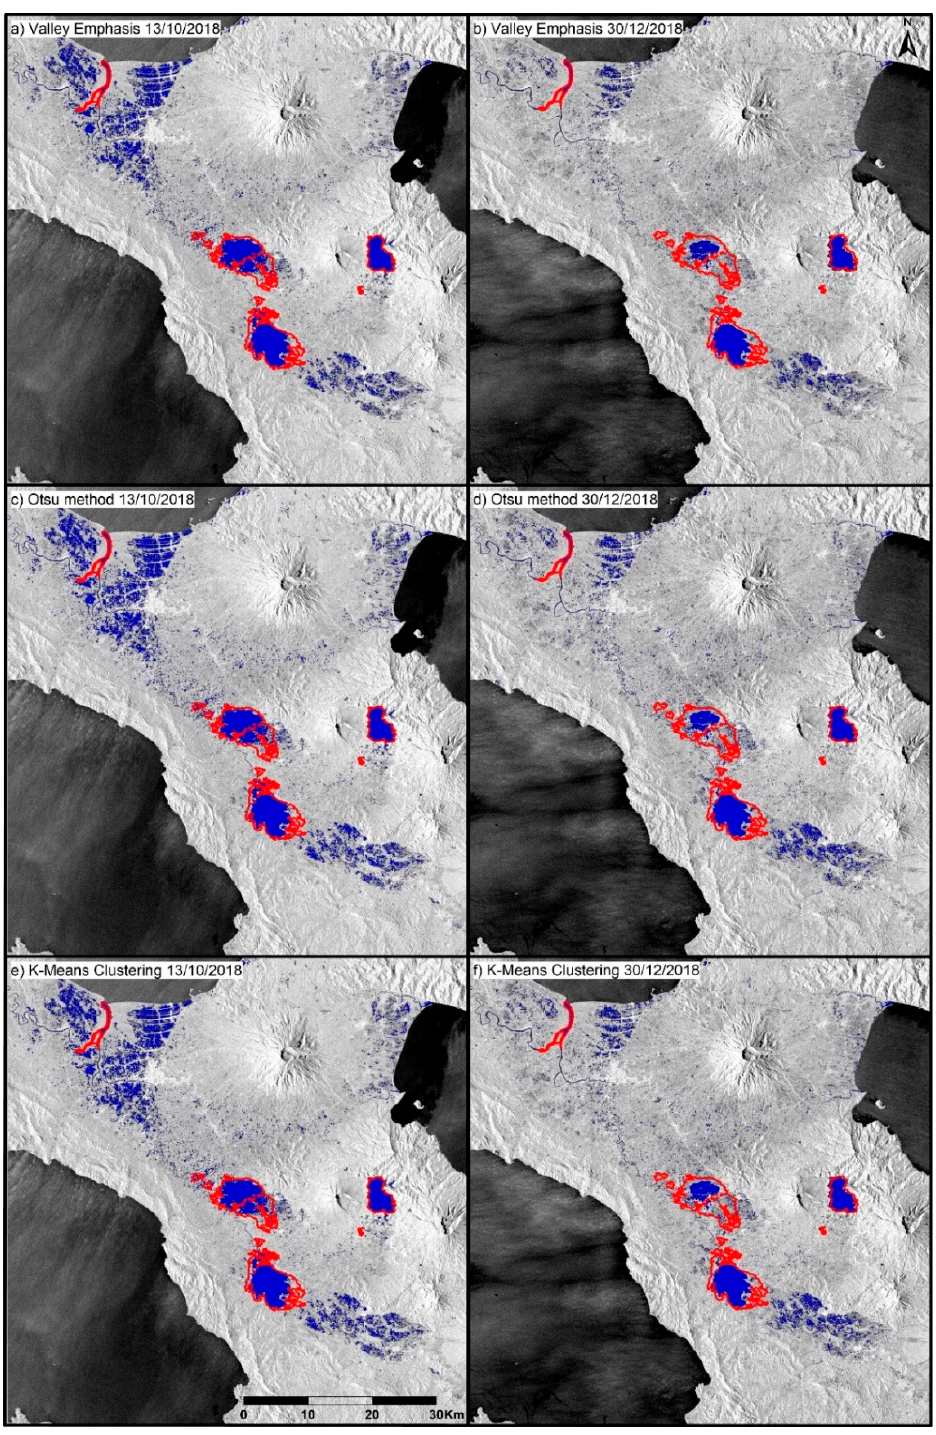
Figure 6. Examples of results in terms of open water extent obtained by multiple methods. Blue areas represent the extracted open water features, and red polygons represent SWBD water body boundaries. ( a,c,e ) represent the extent of open water features after the second rainfall event responsible for the flooding. ( b,d,f ) represent the extent of open water features after the third flood pulse.